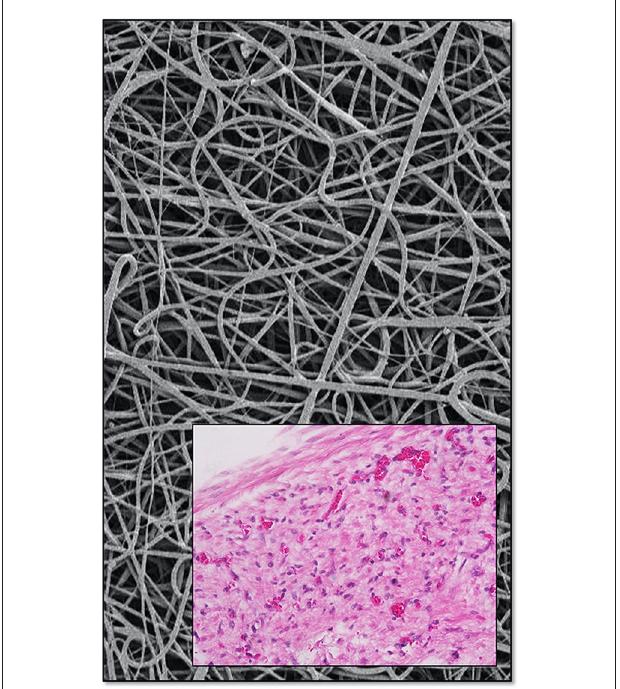
FIGURE 6 | Skirts are electrospun from the same material used for the polymer leaflets. Porosity was shown to allow transmural capillarization [bottom, from (17) with